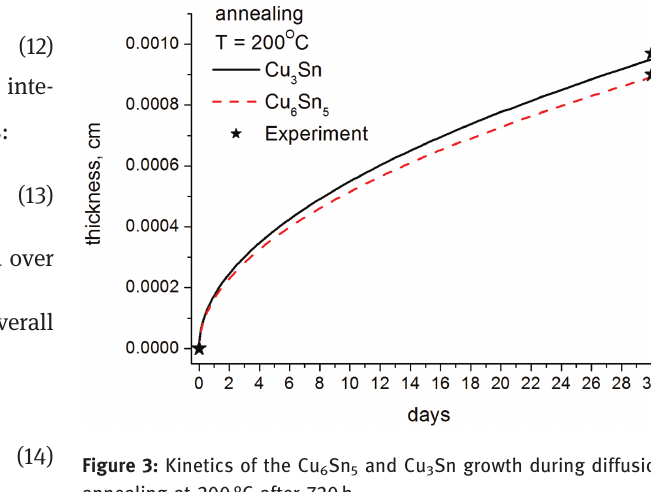
Figure 3: Kinetics of the Cu 6 Sn 5 and Cu 3 Sn growth during diffusion annealing at 200°C after